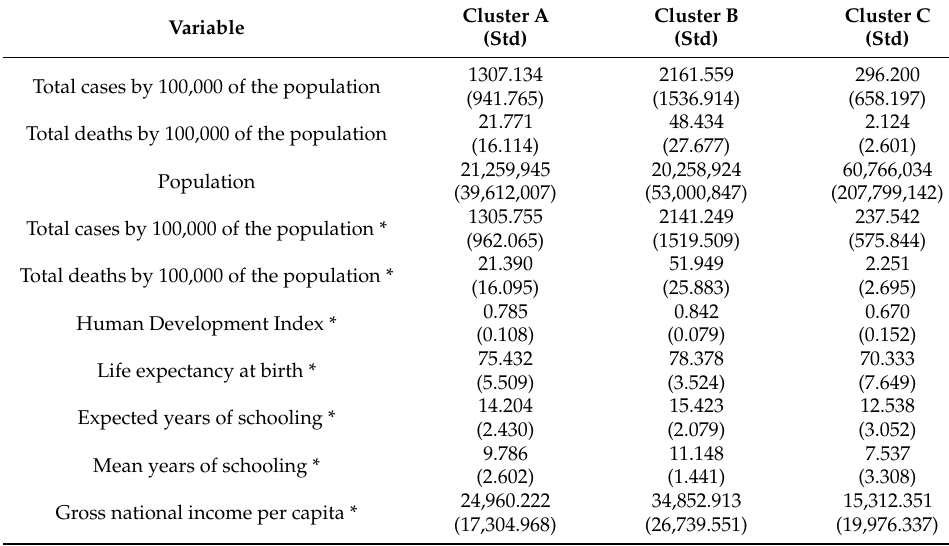
Table 6. Averages and Standard Deviations (Std) of Variables for Each Cluster of Deaths at Day 250 (* Excluding the 24 Countries/Territories That are not Present in the UNDP Dataset).